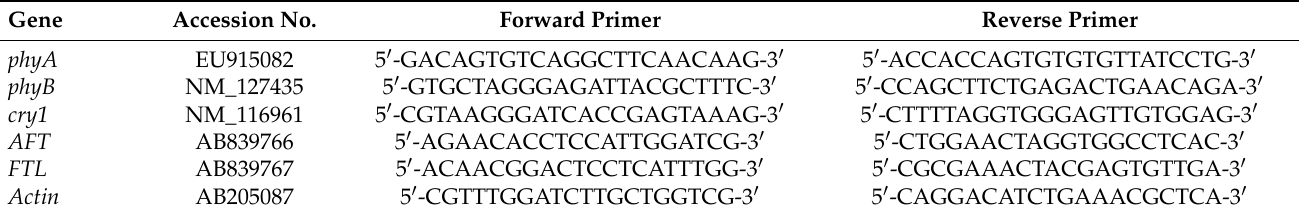
Table 1. Primers for quantifying gene expression